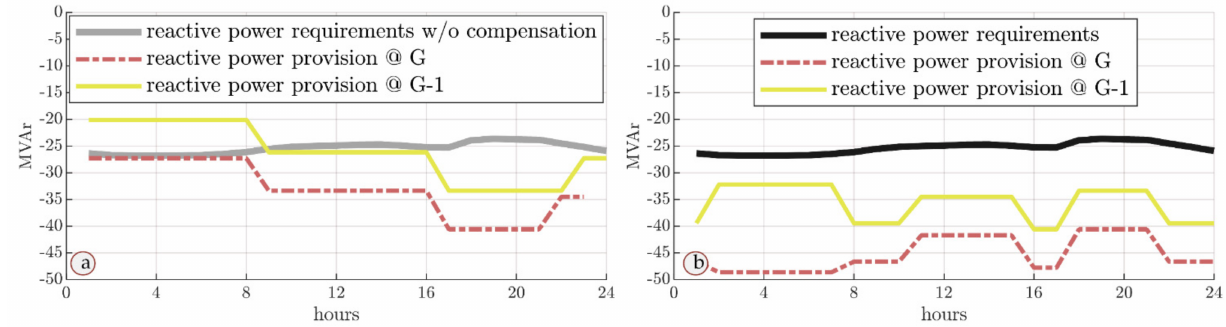
Figure 4. System operation during the lowest demand day of the year ( a ) with full and ( b ) without any reactive compensation scheme.